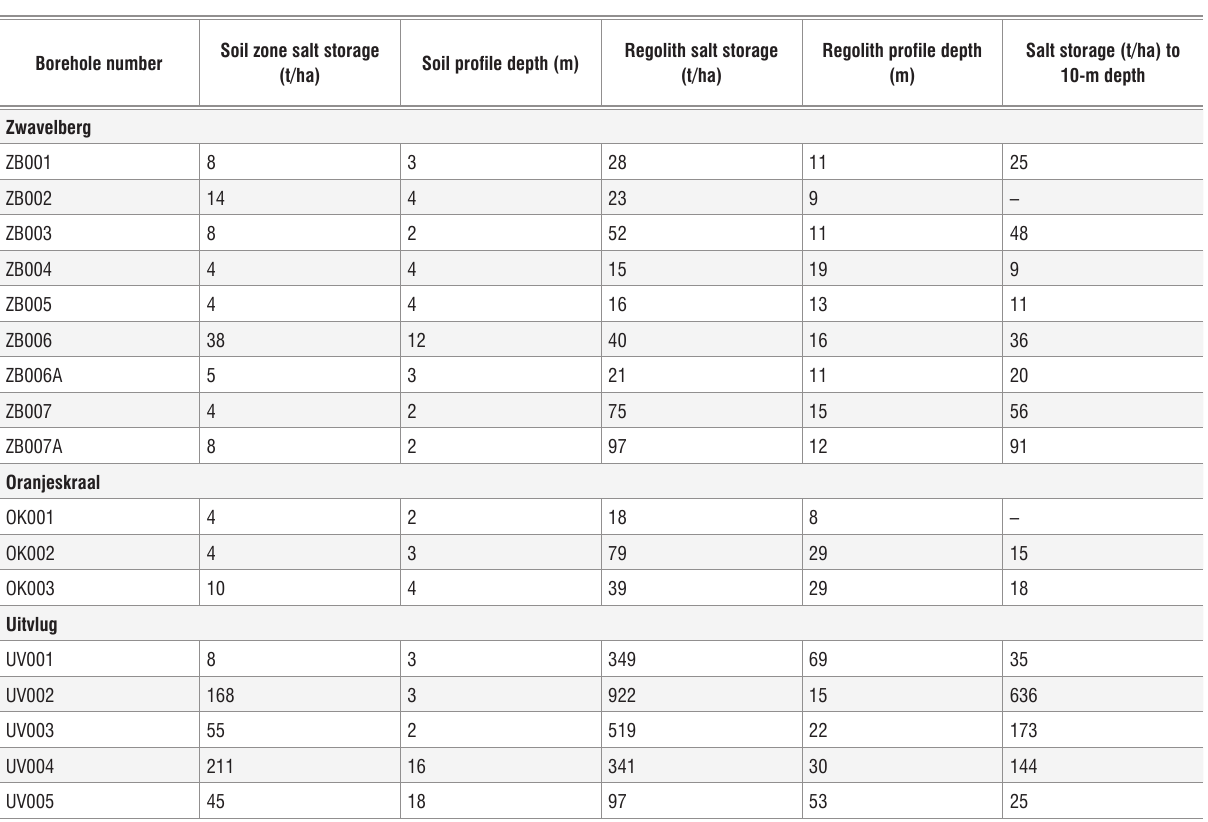
Salt storage (t/ha) in the Sandspruit catchment